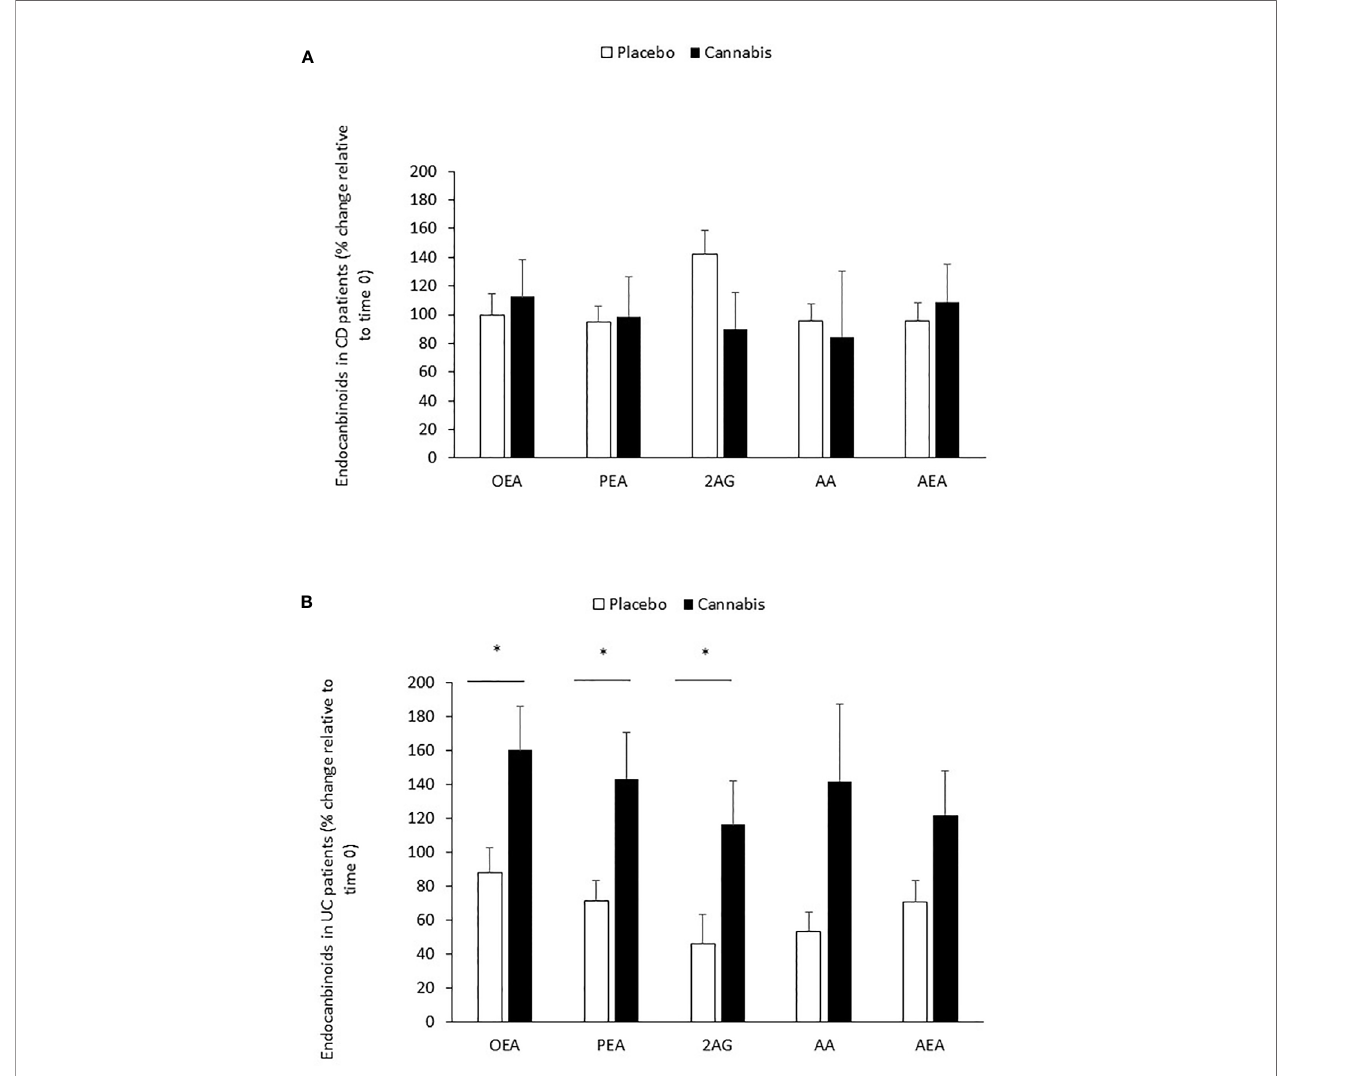
FIGURE 1 | Changes in eCB levels during 8 weeks of cannabis or placebo use. (A) CD and (B) UC patients were treated for 8 weeks with cannabis or placebo. Before the beginning of cannabis/placebo use and 8 weeks later, blood was taken from the patients, and eCB levels were evaluated in the sera by using LC-MS/MS. The line represents eCB levels in time 0 (before cannabis use). *Results signi fi cantly different from time 0 ( p <